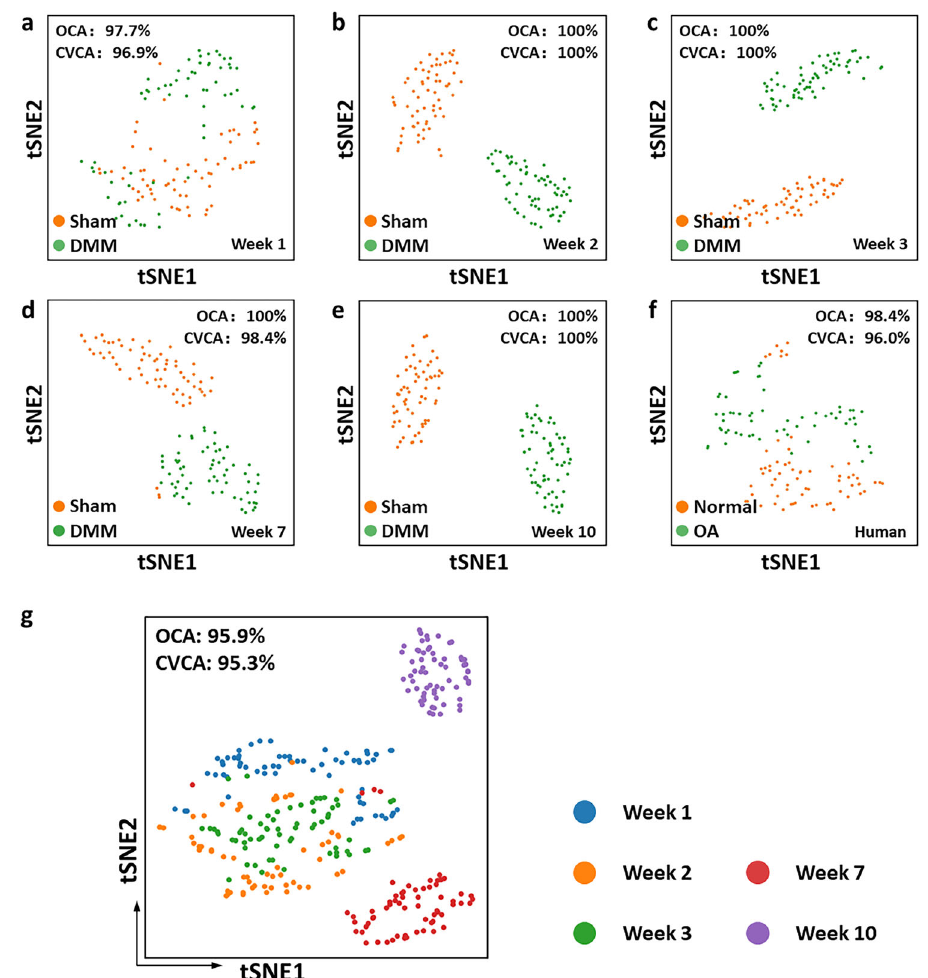
Fig. 6 viSNE-based visualization within and between group separation based on the combination of the six optical metrics. viSNE maps of mouse model data at a Week 1, b Week 2, c Week 3, d Week 7, and e Week 10, and f human specimen data. g Overall viSNE map showing the clustering of fi eld-based data in response to DMM surgery at different time points in the mouse model. DMM data are normalized to the corresponding optical metric mean value from the sham group at each time point. Different colors correspond to different time points, as labeled to the right of the map. OCA and CVCA values are marked in each viSNE